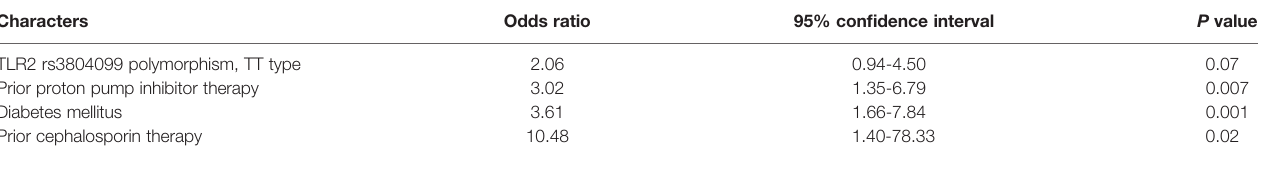
TABLE 2 | Multivariate analysis of risk factors for CDI in 539 patients.